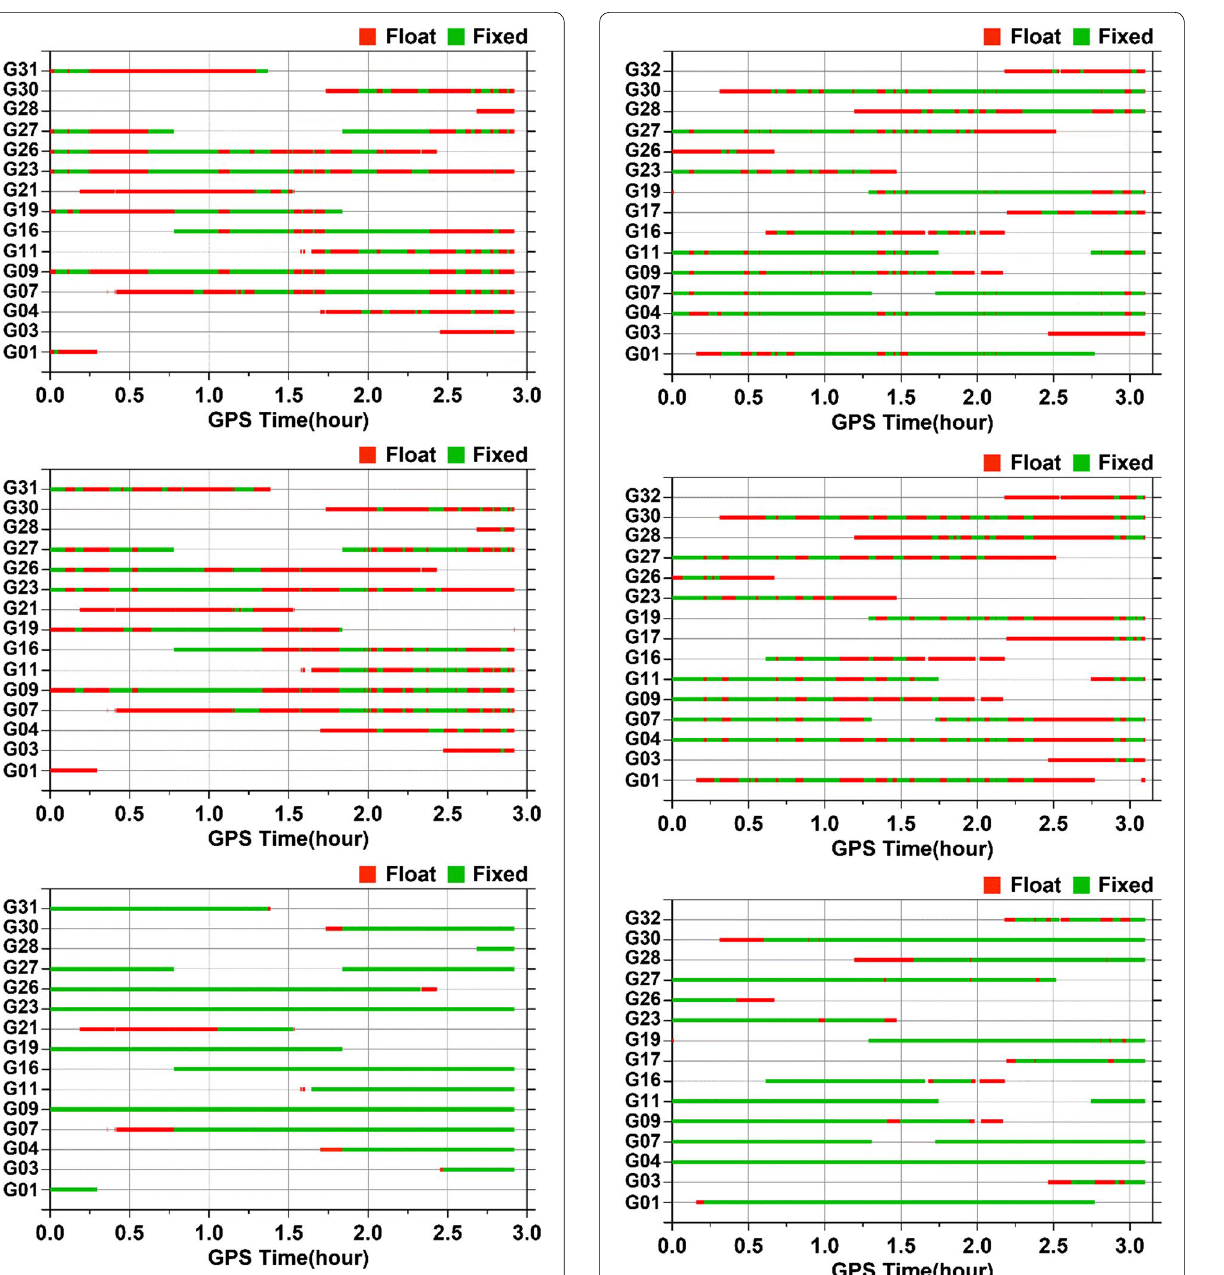
Fig. 6 Ambiguity-fixing in the forward filter (top), backward filter (middle) and the ADBI method (bottom) for airborne data. The red curve denotes the float ambiguity results and the green means the fixed ambiguity results